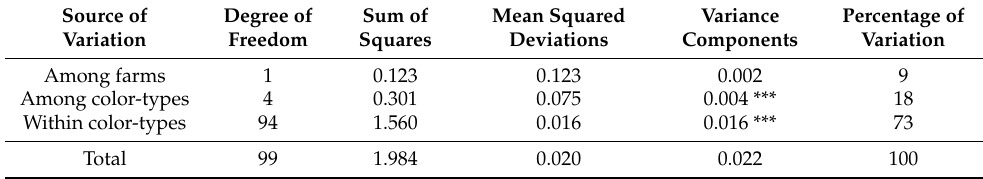
Table 4. Analysis of molecular variance (AMOVA) in different color-types of farmed